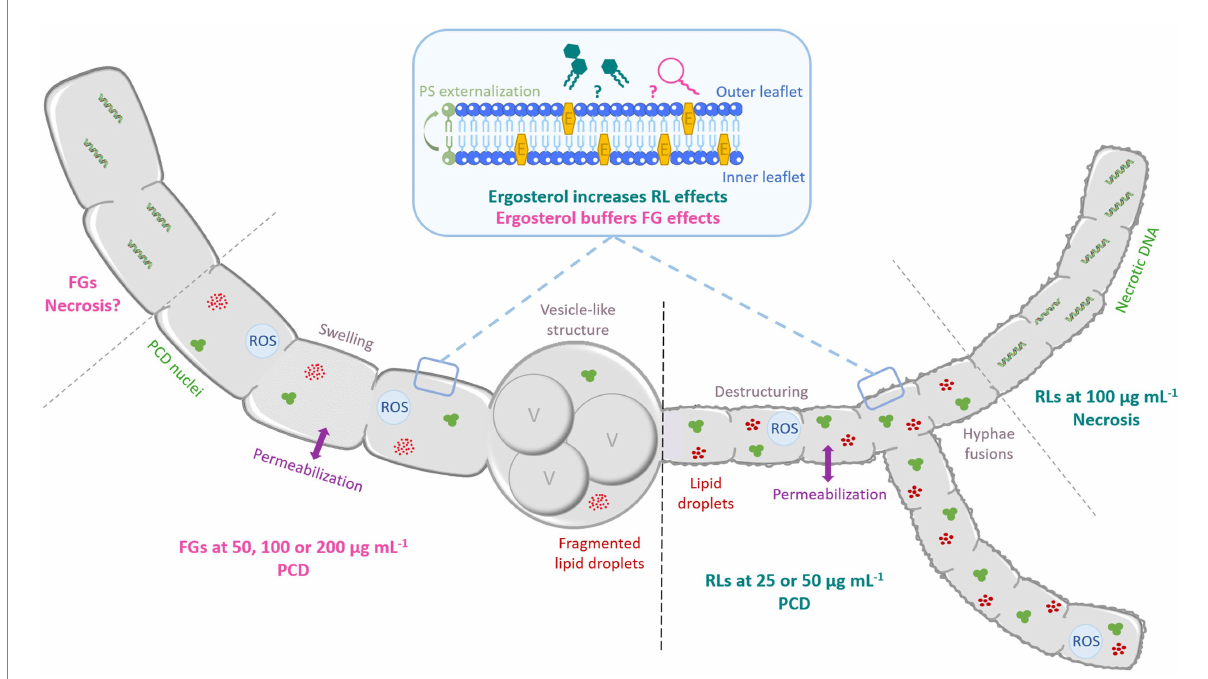
FIGURE 11 Schematic representation of the antifungal mode of action of RLs and FGs on B. cinerea and S. sclerotiorum hyphae according to the concentration. Both compounds induce hyphae permeabilization. RLs induce destructuring and fusion of hyphae. FGs trigger swelling and formation of vesicle-like structures associated to vacuole fusion and lipid droplets degradation. At medium concentration (until 50 μ g mL − 1 ), RLs induce PCD with condensed DNA and fragmented nuclei, ROS production and PS externalization. At 100 μ g mL − 1 , RLs induce necrotic death with DNA fragmentation. FGs trigger PCD at all concentration tested. E: ergosterol, PCD: programmed cell death, PS: phosphatidylserine, ROS: reactive oxygen species, V: